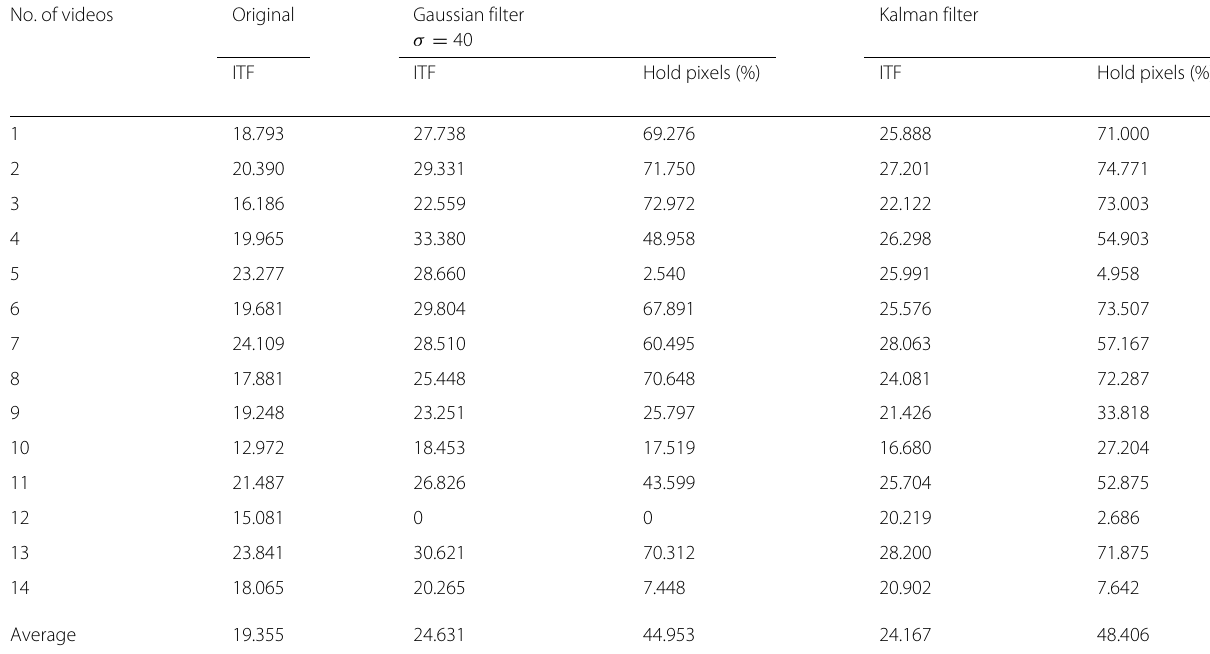
Table 2 Comparison between Gaussian filter and Kalman filter No. of